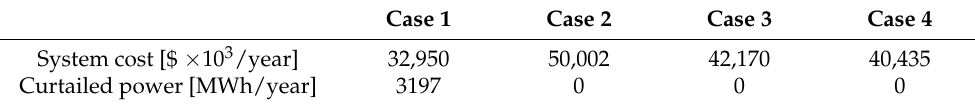
Figure 8. Results of power flow scheduling in Case 4. Table 4. Optimization results of each case.